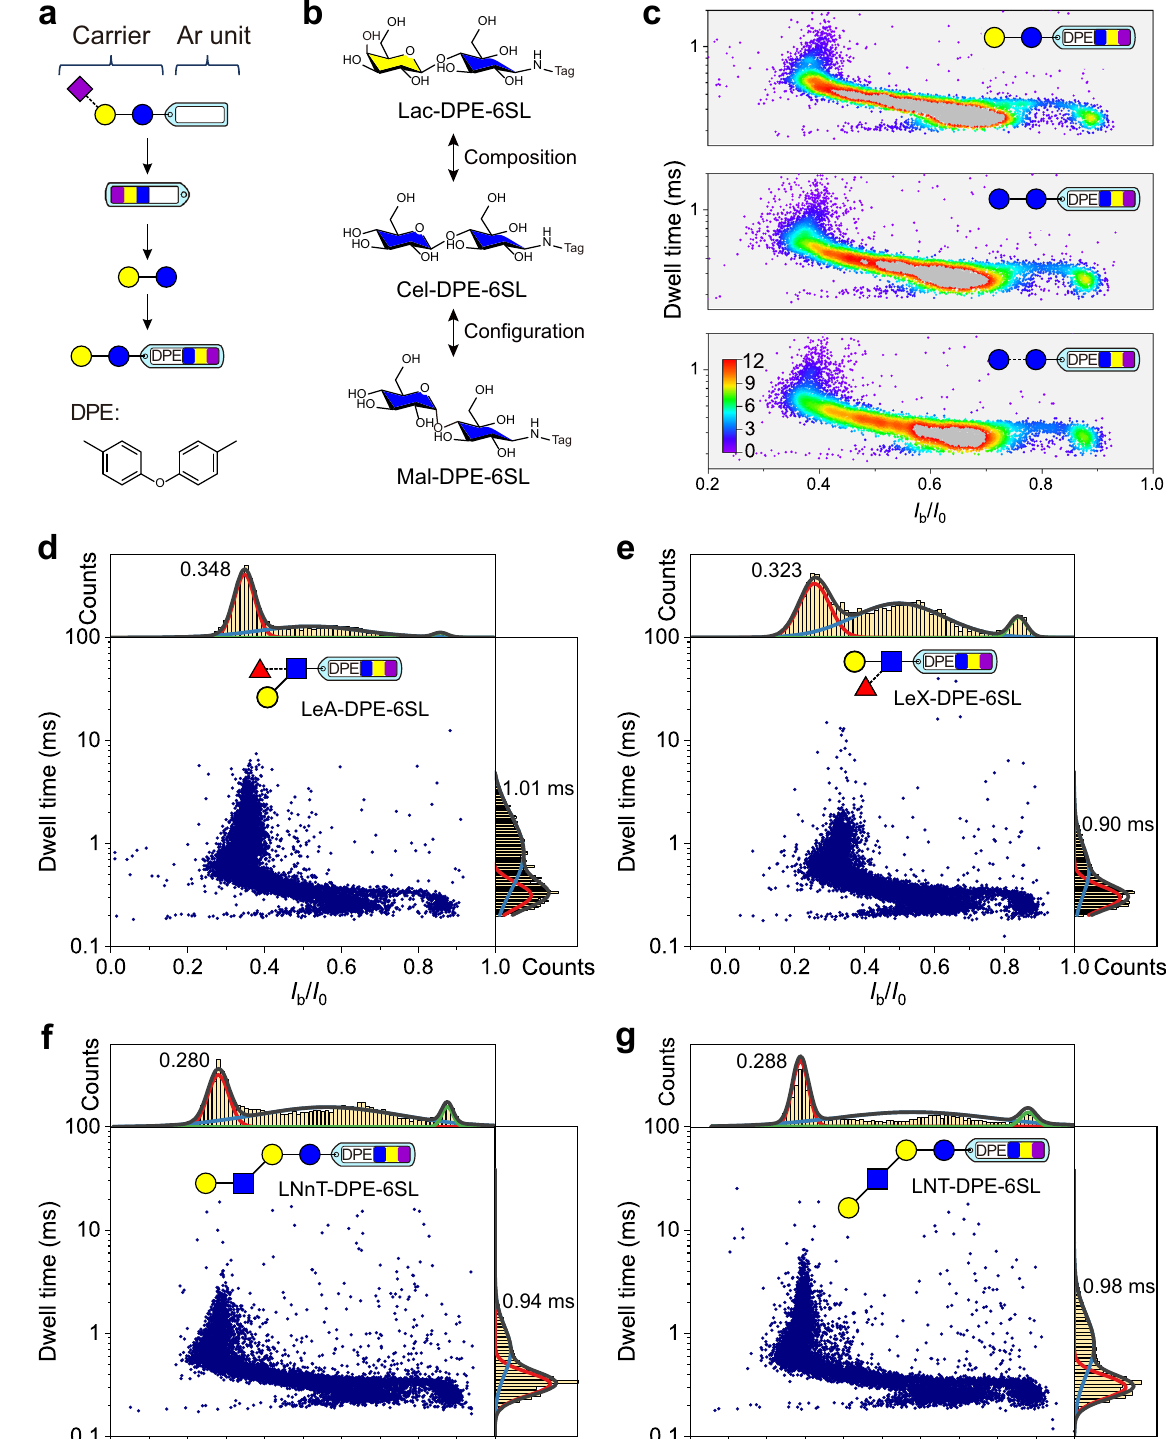
Fig. 3 | Nanopore detection ofneutral glycans. a Schematic of the derivatization strategy of neutral glycan (Lac, for example). The complex label contains 6SL as a carrier and diphenyl ether (DPE) as the aromatic (Ar) unit. b Three complex label tagged disaccharide epimers (Lac-DPE-6SL, Cel-DPE-6SL, and Mal-DPE-6SL) that differ only in the C4 or C1 stereochemistry of the terminal monosaccharide. c Dot density maps ofnanoporedata ofthree disaccharide derivatives. Scatter plotsand the corresponding I b / I 0 and dwell time distributions of two complex label tagged